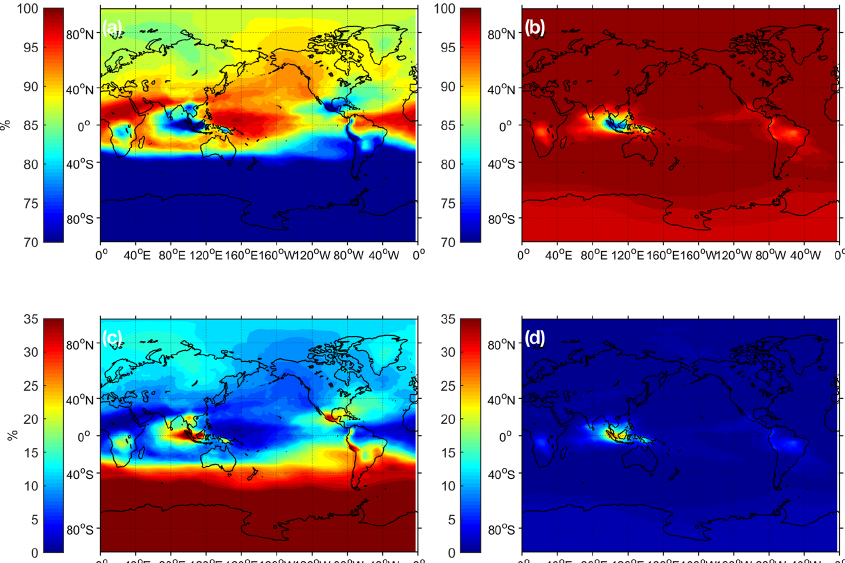
Figure 4. Annually averaged contributions of dust and BC to heterogeneously formed ice crystal number. (a) Dust contribution in PDA08; (b) dust contribution in PDA13; (c) black carbon contribution in PDA08; and (d) black carbon contribution in